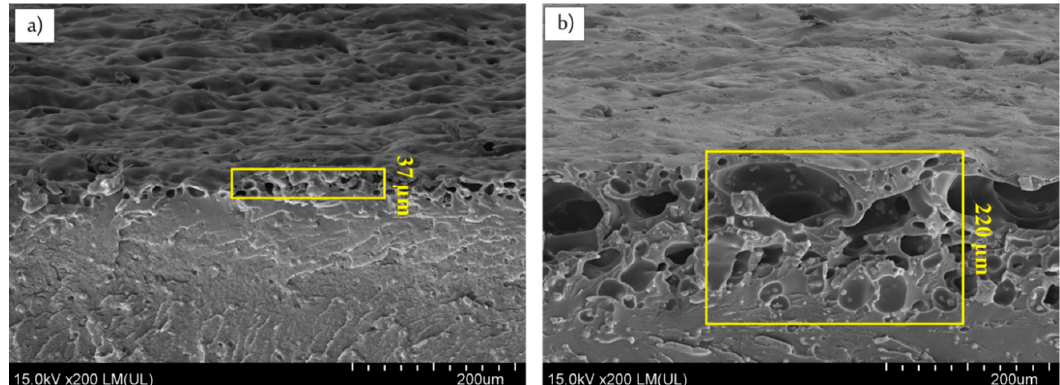
Figure 8. SEM images (side views) of composite E irradiated with ( a ) CO 2 and ( b ) Nd:YAG lasers